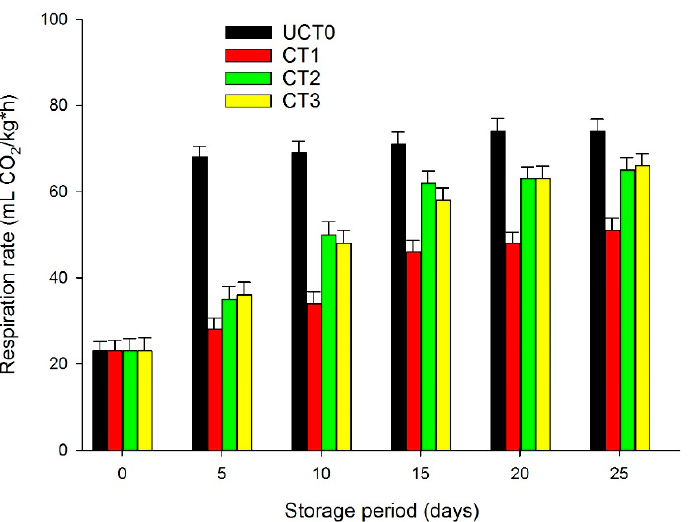
Figure 7. Respiration rate (mL CO 2 /kg*h) of Golden Delicious apple slices coated (with CT1, CT2, and CT3), and not treated (UCT0) at day 0, and after 5, 10, 15, 20, and 25-days of storage at 4 °C in dark conditions and 85% relative humidity (RH). Values indicate the means ± standard deviations ( n = 3). Abbreviations: UCT0, uncoated apple slices used as control; CT1, apple slices coated with chitosan-glycerol-cinnamon oil; CT2, apple slices coated with guar gum-glycerol-cinnamon oil; CT3, apple slices coated with composite guar gum-starch-glycerol-cinnamon oil.